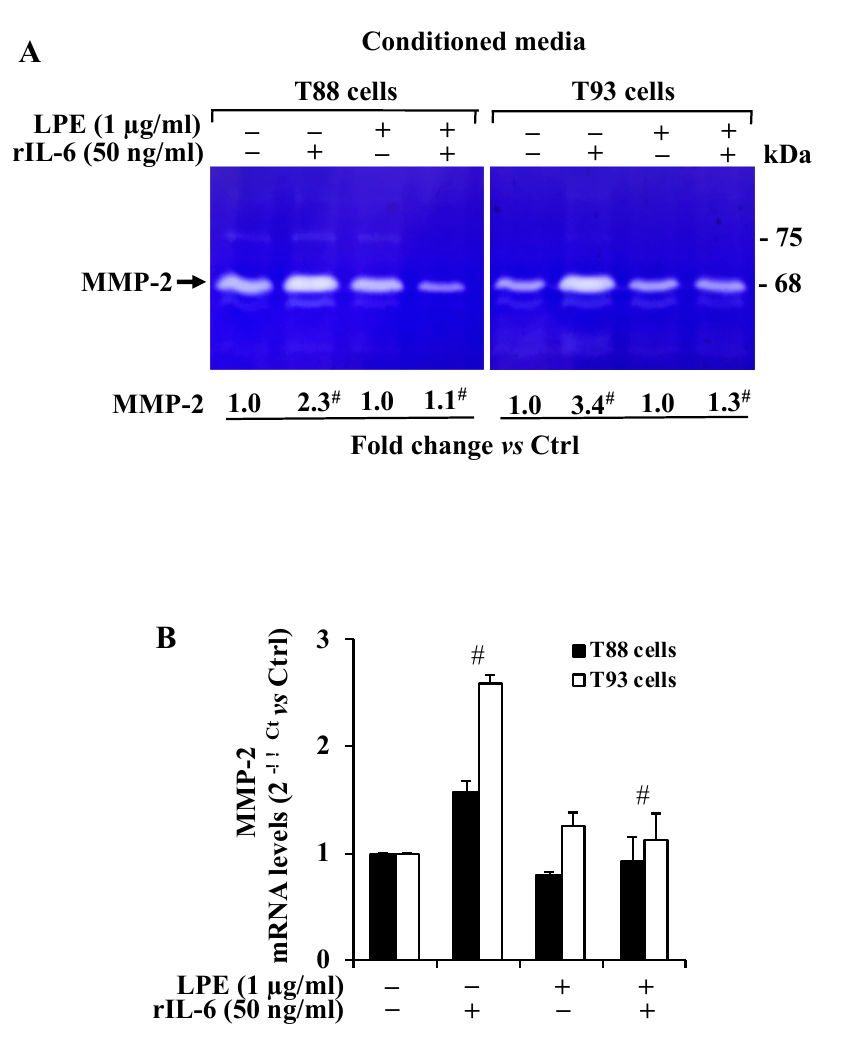
Figure 3. Effect of rIL-6 exposure with or without LPE pretreatment on MMP-2 gelatinase activity and mRNA expression levels. ( A ) Gelatinolytic activity in T88 and T93 cells revealed by gel zymography. Cells, pretreated with LPE (1 µ g/mL GAE) for 6 h, were then exposed to rIL-6 (50 ng/mL) for a further 24 h. After the treatments, the conditioned media were collected, and the cells harvested for cell protein and mRNA preparation. Cell-conditioned media were concentrated by ultrafiltration, and volumes corresponding to 40 µ g of cell proteins were analyzed under non-reducing conditions through a 12% SDS-polyacrylamide gel co-polymerized in the presence of gelatin (1 mg/mL). ( B ) MMP-2 mRNA expression levels in T88 and T93 analyzed by qPCR analysis. Expression levels of MMP-2 mRNA of the treated cells were calculated vs. the untreated cells, set to 1. Results are presented as mean ± SD ( n = 3) (# p < 0.001, statistically significant vs. untreated cells).